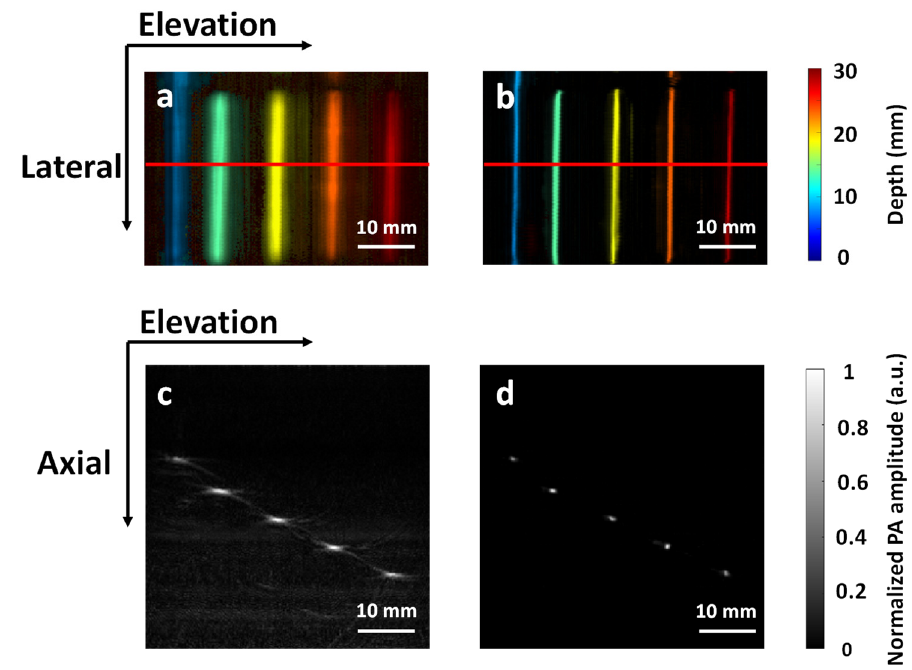
Figure 5. Imaging results of pencil leads at different depths. ( a ) Input reconstructed by the 3D focal-line algorithm. ( b ) Combined (2D Deep-E and 3D Deep-E) output. ( c ) Cross-sectional image obtained from the location indicated by the red line in ( a ). ( d ) Cross-sectional image obtained from the location indicated by the red line in ( d ).